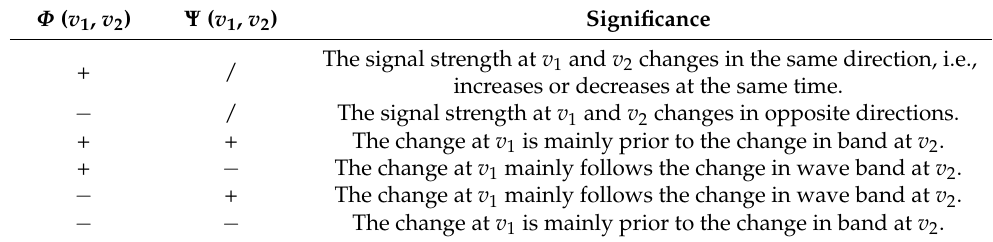
Table 1. The direction and sequence of intensity changes according to Noda’s rule. Φ ( v 1 , v 2 ) Ψ ( v 1 , v 2 ) Significance The signal strength at v 1 and v 2 changes in the same direction, i.e., + / increases or decreases at the same time. − / The signal strength at v 1 and v 2 changes in opposite directions. + + The change at v 1 is mainly prior to the change in band at v 2 . + − The change at v 1 mainly follows the change in wave band at v 2 . − + The change at v 1 mainly follows the change in wave band at v 2 . − − The change at v 1 is mainly prior to the change in band at v 2